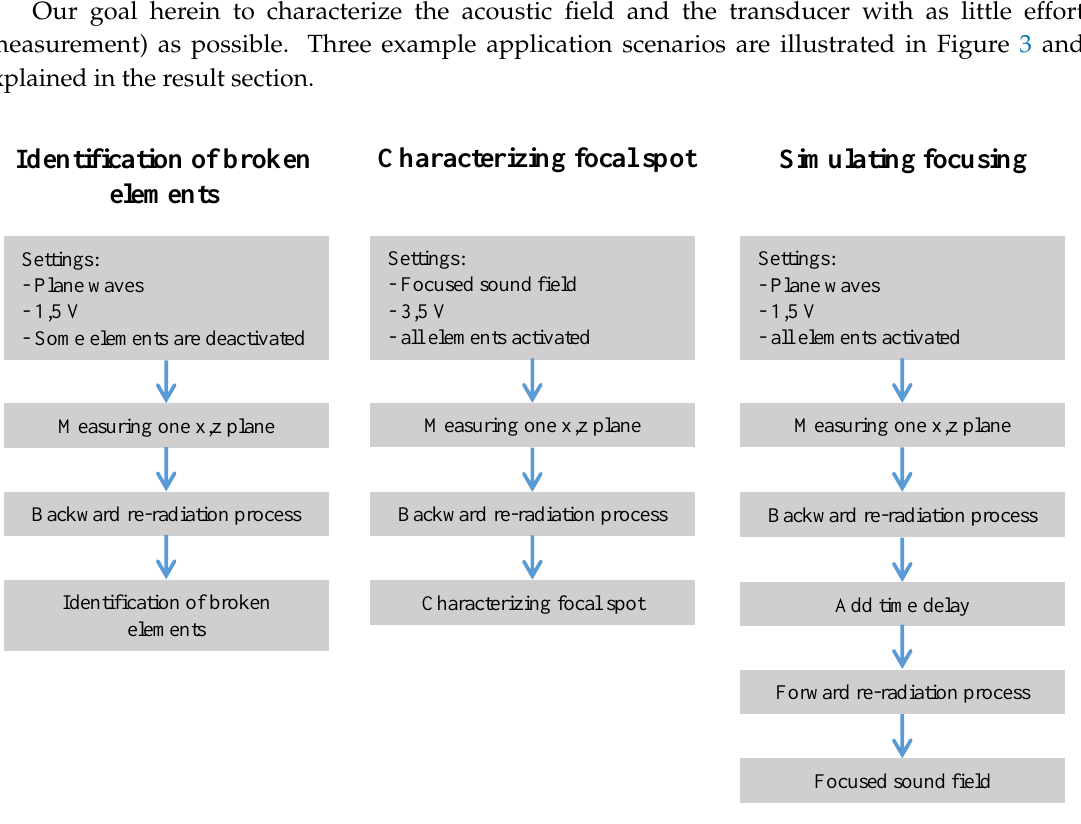
Figure 3. Performed examinations and